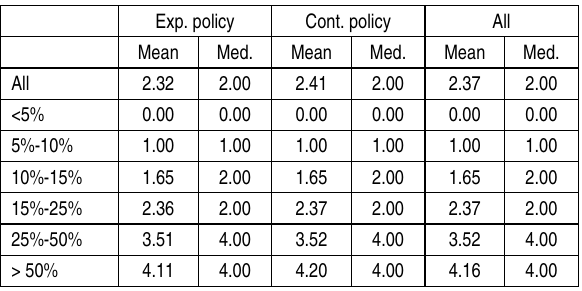
Table 3. Number of blockholders across monetary policy periods